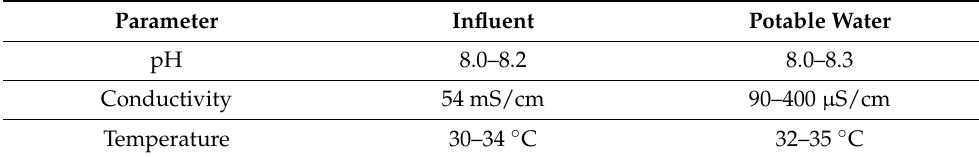
Table 2. The water properties of the seawater reverse osmosis influent and effluent (potable). Parameter Influent Potable Water